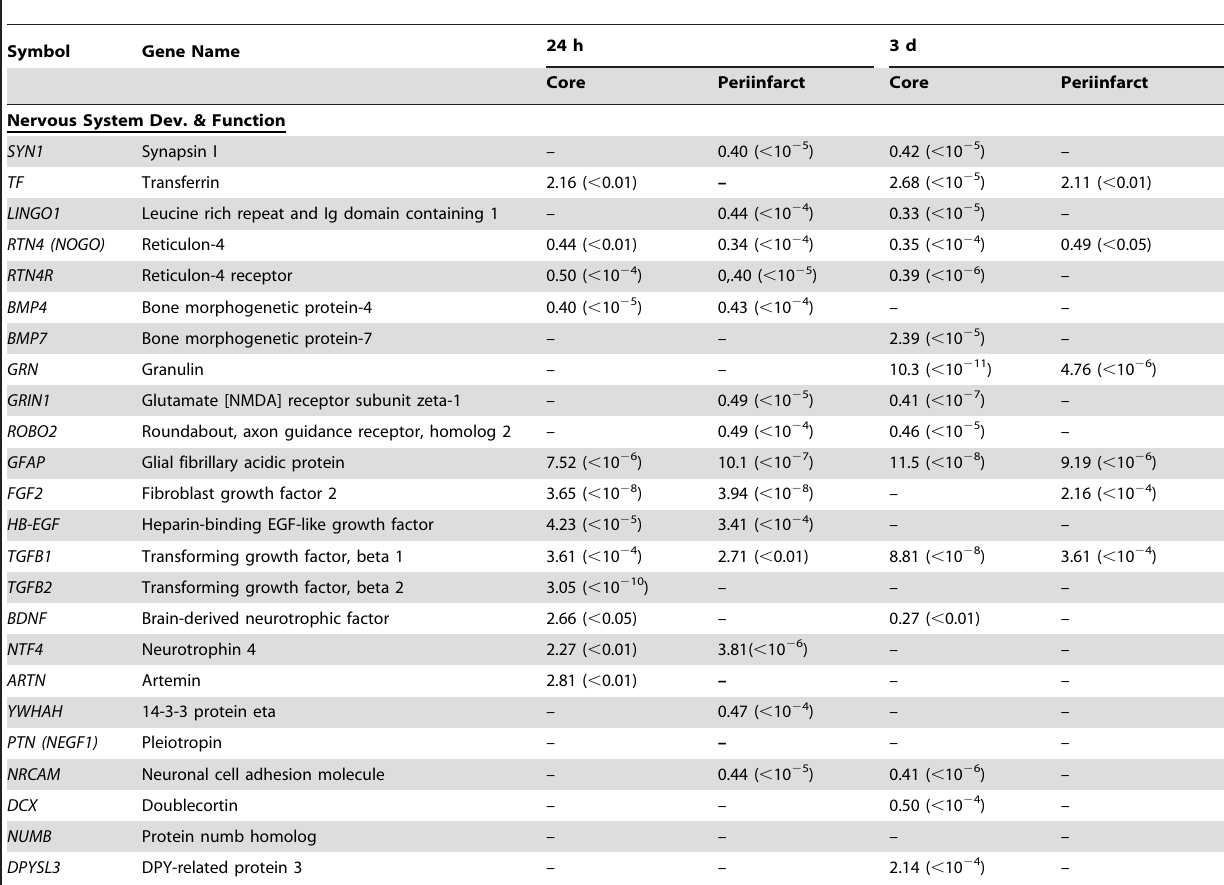
Table 5. Regulation of nervous system development and function-associated genes in the core and periinfarct after permanent focal cerebral